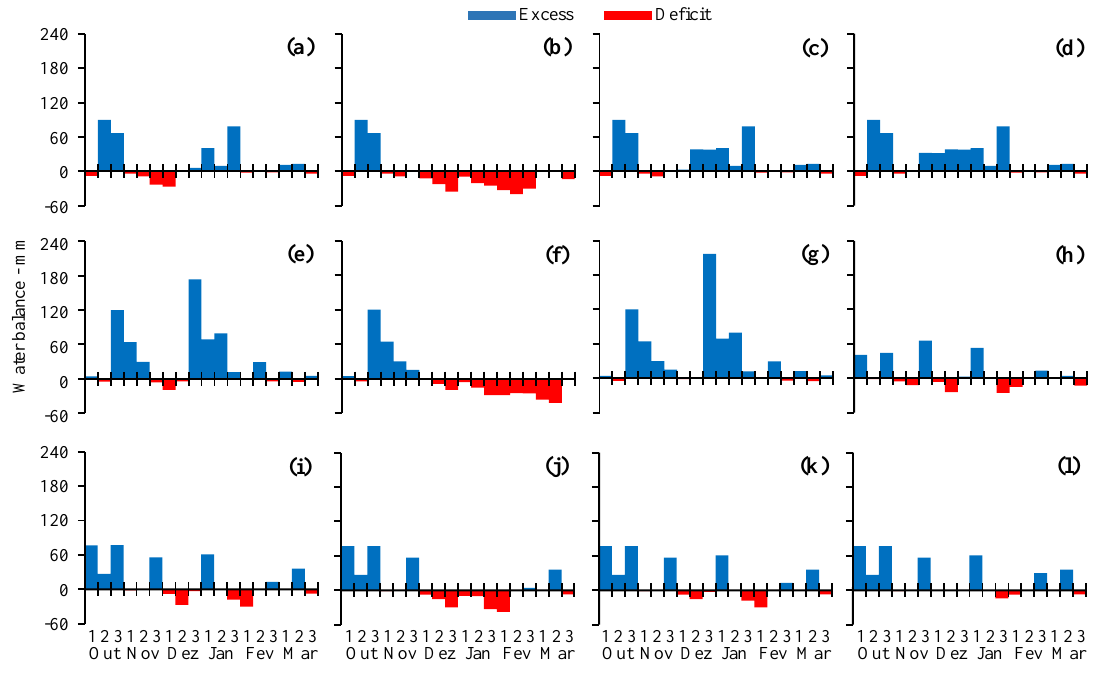
Figure 4. Climatic water balance at 10-day periods in the DIV ( a ), DIR ( b ), NIRR ( c ), and IRR ( d ) treatments on the 2016/2017 cropping season, at Embrapa Soja; DIV ( e ), DIR ( f ), and NIRR ( g ) treatments on the 2017/2018 cropping season, at Embrapa Soja; NIRR ( h ) treatment on the 2018/2019 cropping season, at Unoeste University; DIV ( i ), DIR ( j ), NIRR ( k ), and IRR ( l ) treatments on the 2018/2019 cropping season, at Embrapa Soja.